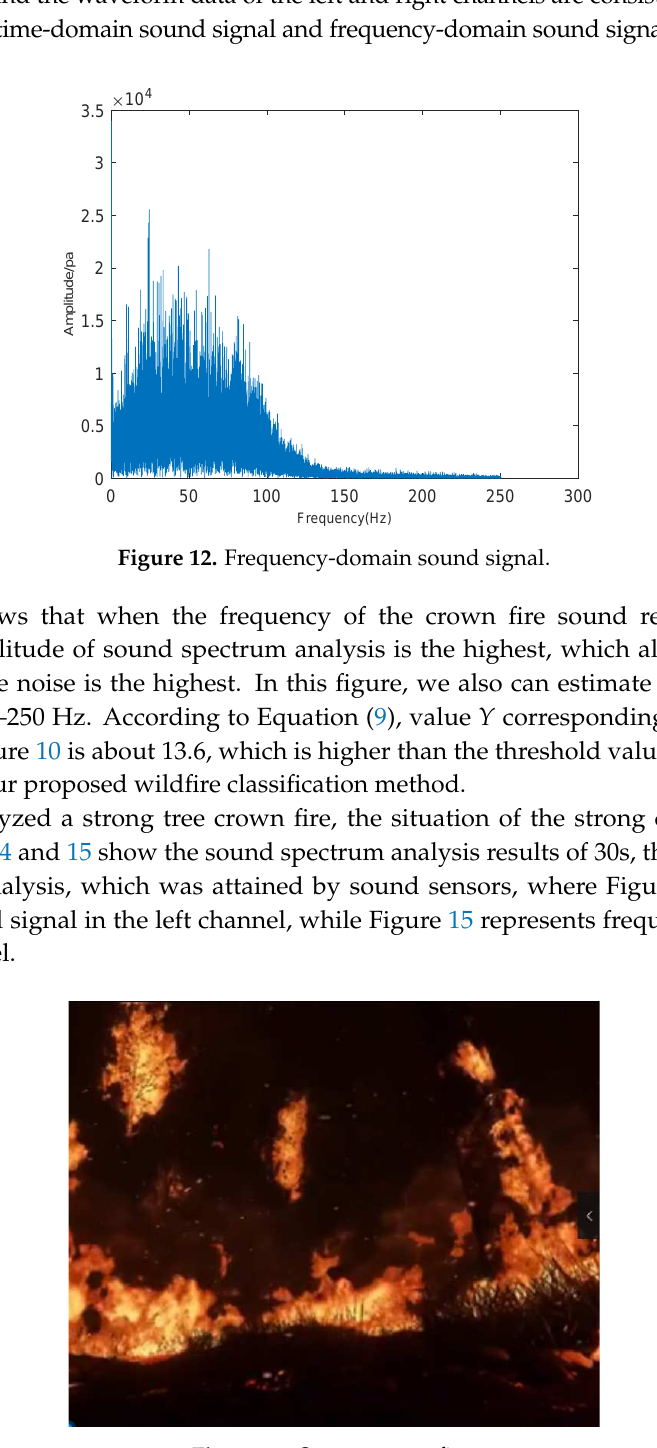
Figure 13. Strong crown